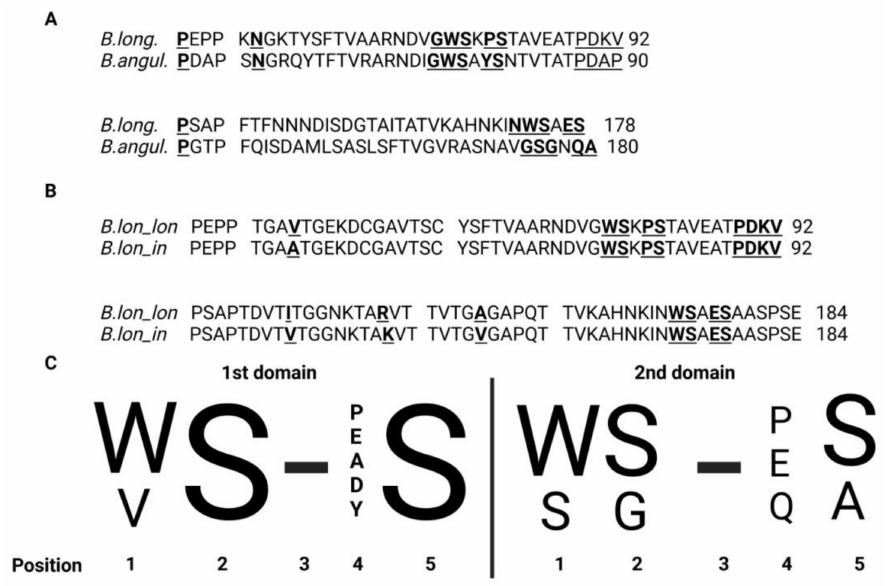
Figure 4. ( A ) Alignment of sequences of protein fragments containing two FN3 domains derived from B. longum GT15 and B. angulatum GT102 (identity 40.1%; similarity 68.7%). Cytokine motifs in these species of bifidobacteria exhibited the starkest differences. The amino acids interjected between the domains are underscored. Amino acids in the “Cytokine receptor motif” site are highlighted by a double under-score. Amino acids in the “Interdomain contacts” site are highlighted in bold and underlined. ( B ) Alignment of sequences of protein fragments containing two FN3 domains from B. longum subsp. longum and B. longum subsp. infantis (identity 97.8%; similarity 100%). Differences in amino acid sequences in the first domain of FN3: 43 V → A; in the second domain FN3: 101 I → V, 109 R → K and 132 A → V. The amino acids interjected between the domains are underscored. Amino acids in the “Cytokine receptor motif” site are highlighted by a double under-score. Amino acids in the “Interdomain contacts” site are highlighted in bold and underlined. ( C ) This logo diagram resulted from aligning the corresponding aminoacid sequences of the gut-dwelling species B. longum , B. adolescentis , B. bifidum , B. breve , B. catenulatum , B. pseudocatenulatum , B. dentium , B. angulatum , B. kashiwanohense and B. gallicum . The motif in the second domain marked by an arrow is unique to B. angulatum . Any amino acid can be in position 3. Adapted from